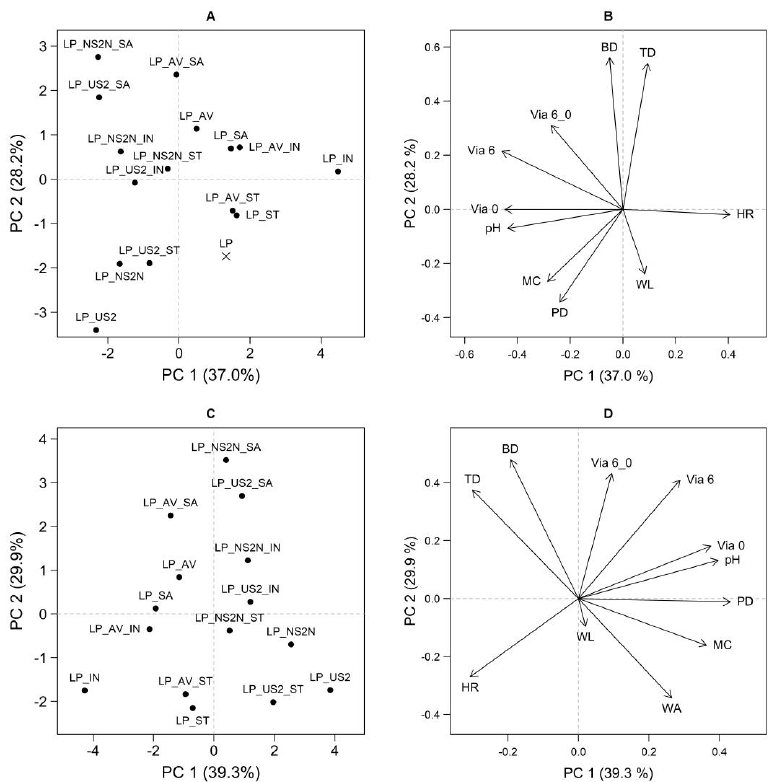
Figure 5. PCA scores plot and loadings plot for model including all samples ( A , B ) and model after exclusion of LP sample ( C , D ). Variables: weight loss (%); pycnometric density (PD); bulk density (BD); tapped density (TD); Hausner ratio (HR); pH leaching (pH); moisture content (MC); water absorption ratio (WA); and viability at time 0 month (Via 0), 6 months (Via 6), and viability maintenance (Via 6_0).